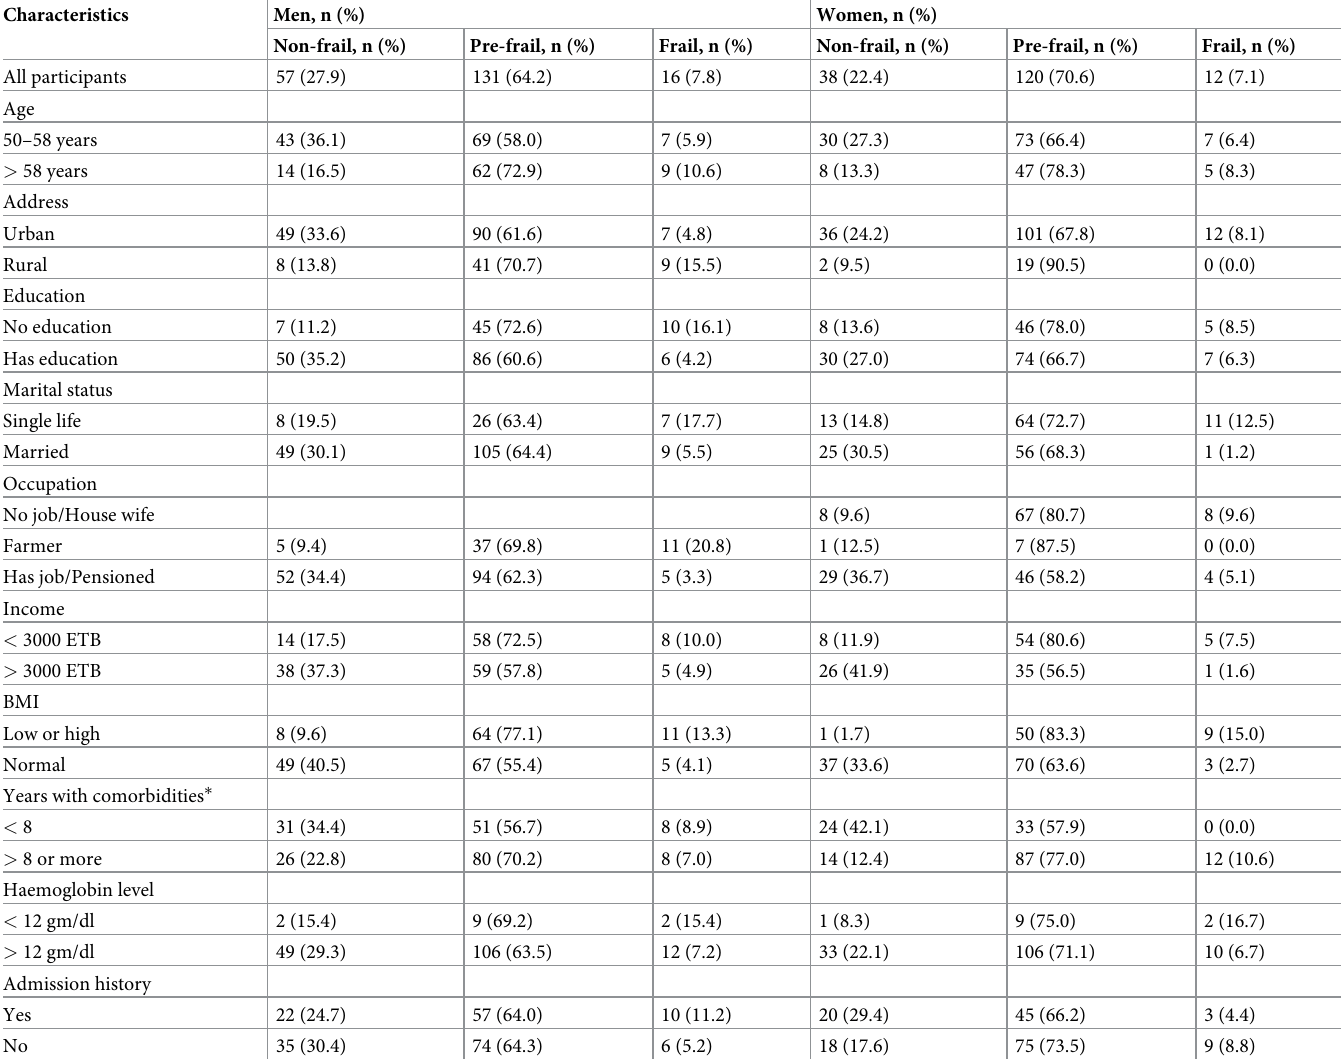
Table 4. Proportion of frail, pre-frail and non-frail by gender.